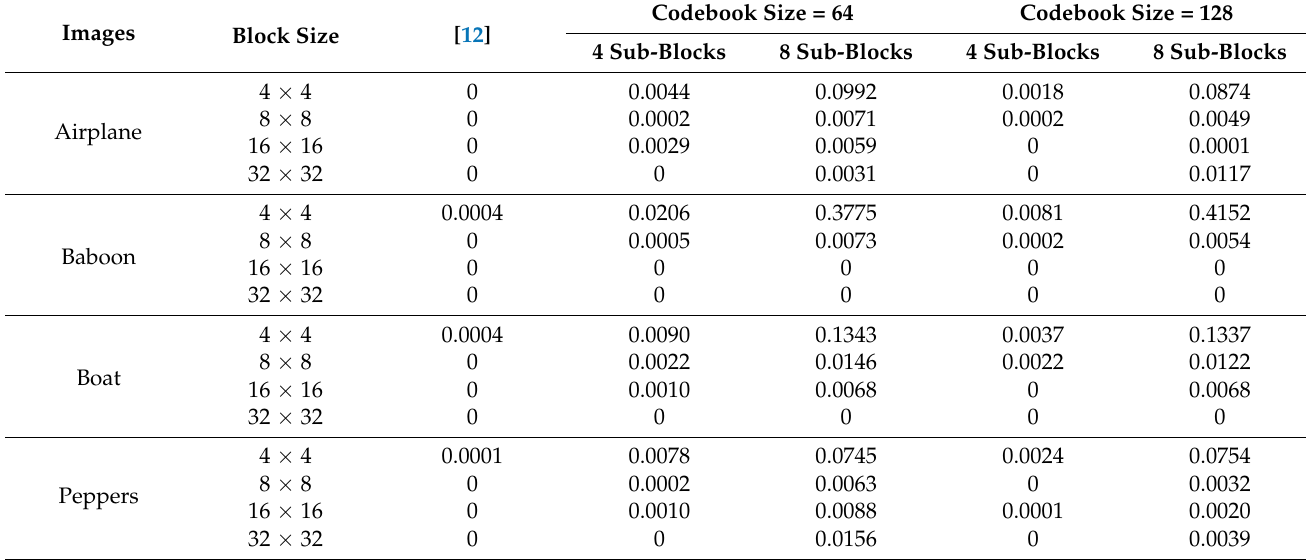
Table 11. Comparison of Error Rate ε (%).